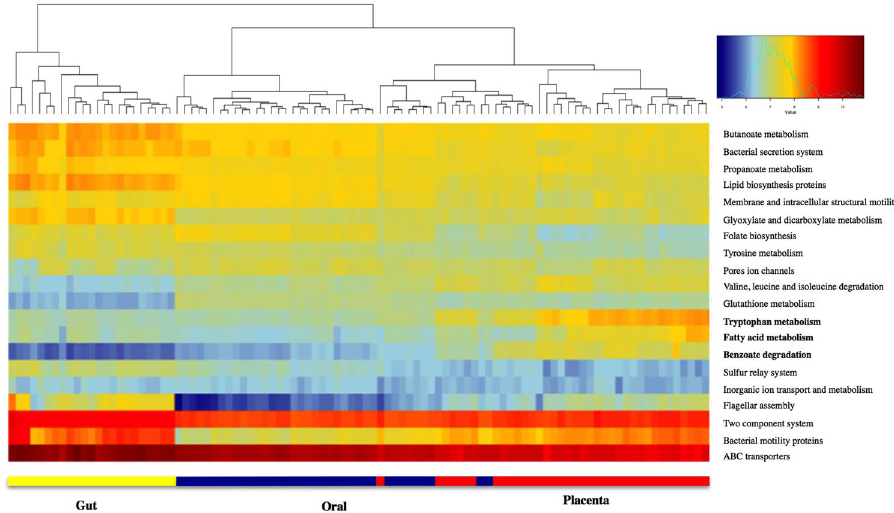
Figure 4. Distinct predictive metabolic profile in the placental microbiome. Heat map demonstrating the predictive functional profiling of microbial communities in the placenta, gut and oral samples, using 16s rRNA gene sequences. Stronger intensity of red indicates higher pathway activity and blue lower activity. Significant microbial functional pathways determined by the LEfSe algorithm are displayed in this heat map (LDA score > 3.0). Bolded pathways were significantly enriched in the placenta in comparison to the maternal oral and gut